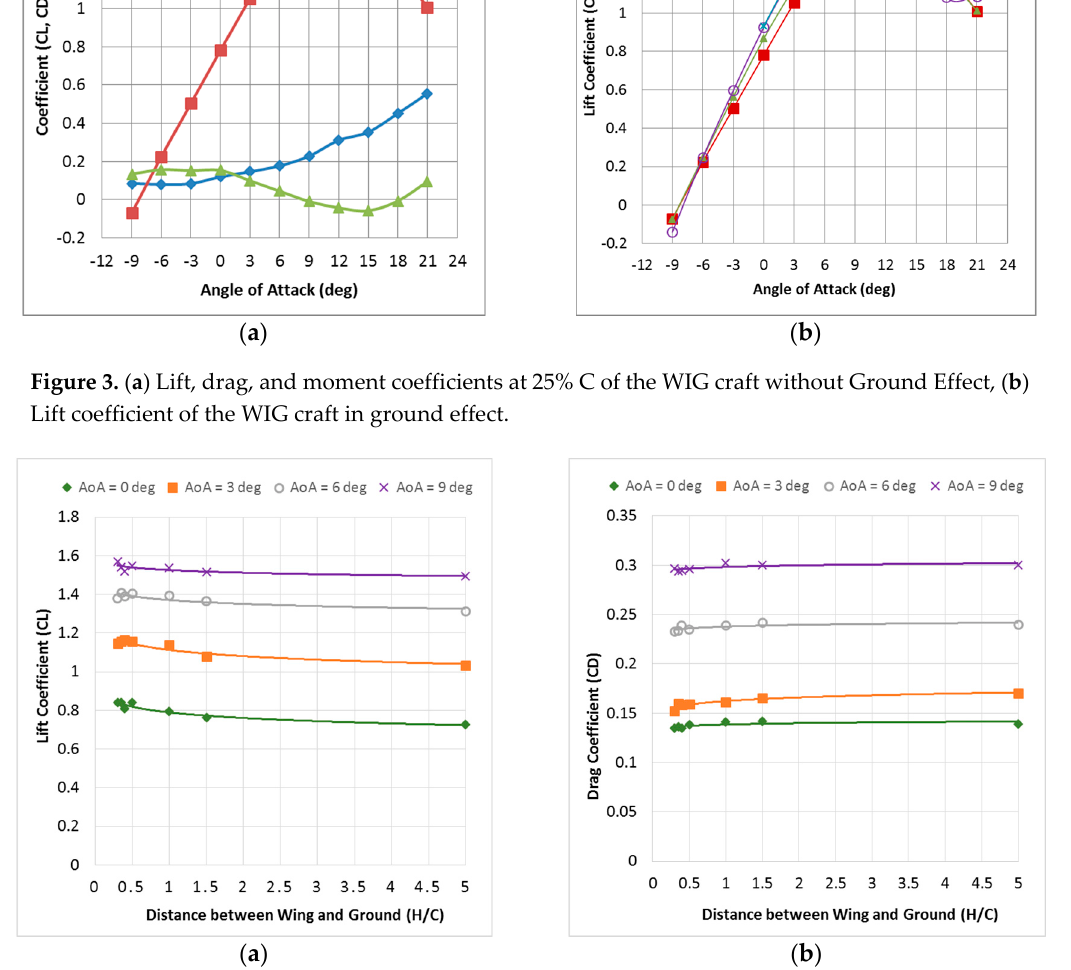
Figure 4. ( a ) Lift coefficient vs wing to ground distance, ( b ) Drag coefficient vs wing to ground